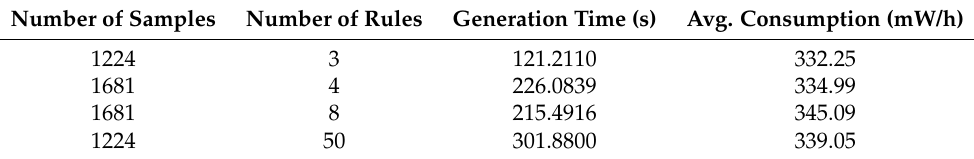
Table 10. Battery consumption of the implemented method per generated cluster or